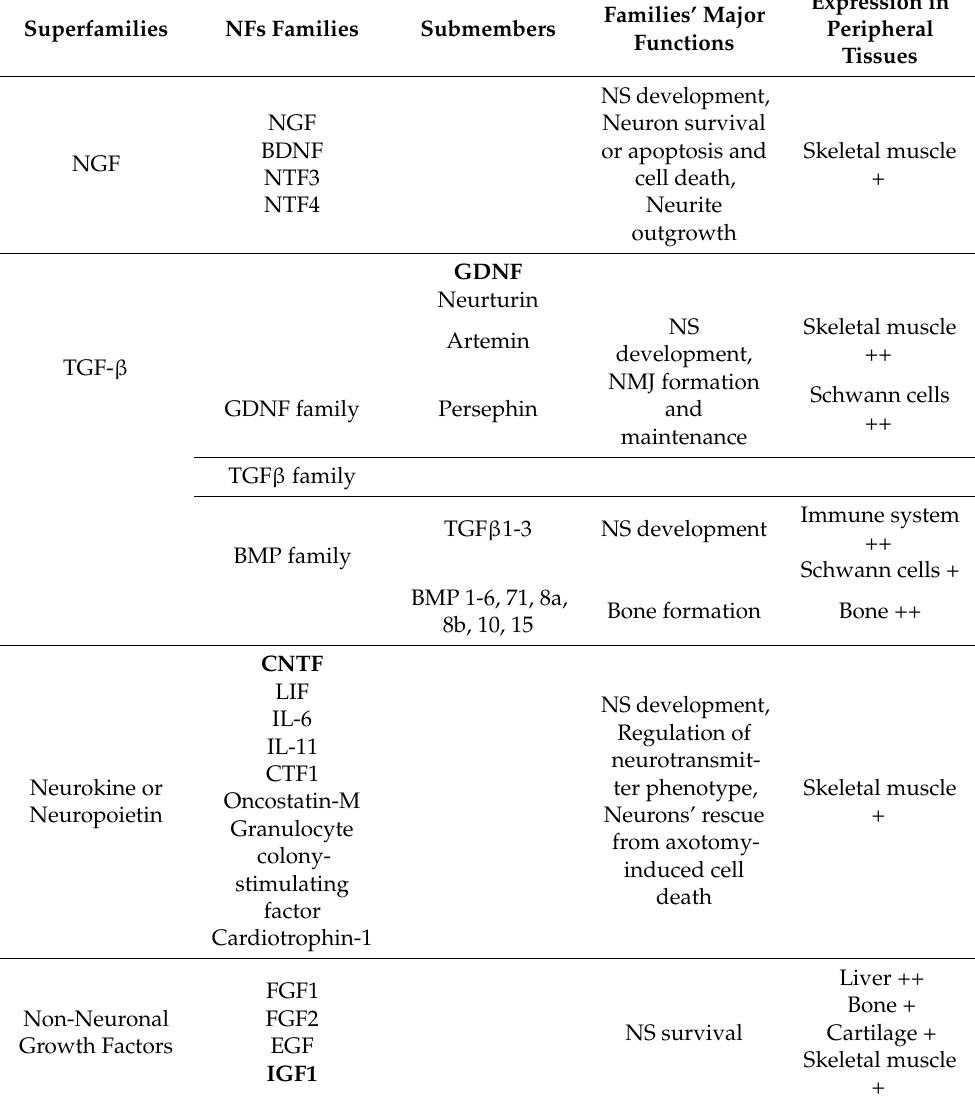
Table 1. NF superfamilies, families and sub-members’ major functions and expression at the periph- eral level. Human NFs are listed in the table. Symbols + or + + are used to indicate the degree of expression and level of secretion in peripheral tissues under physiological conditions: + low levels; + + high levels. The expression levels in peripheral tissues of the NFs in bold (GDNF, CNTF and IGF1) are the most representative of the